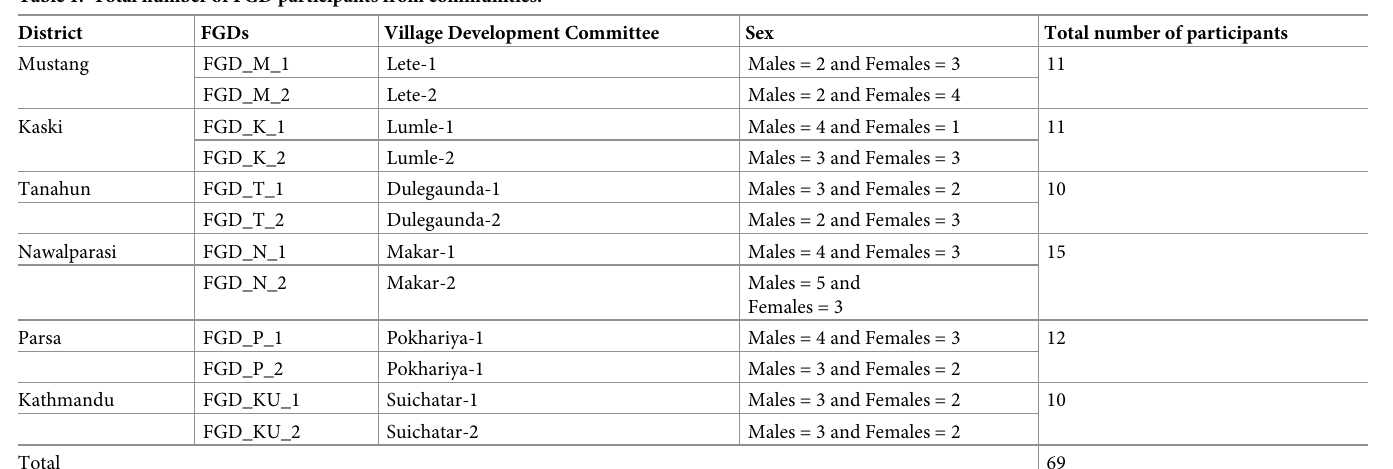
Table 1. Total number of FGD participants from communities.